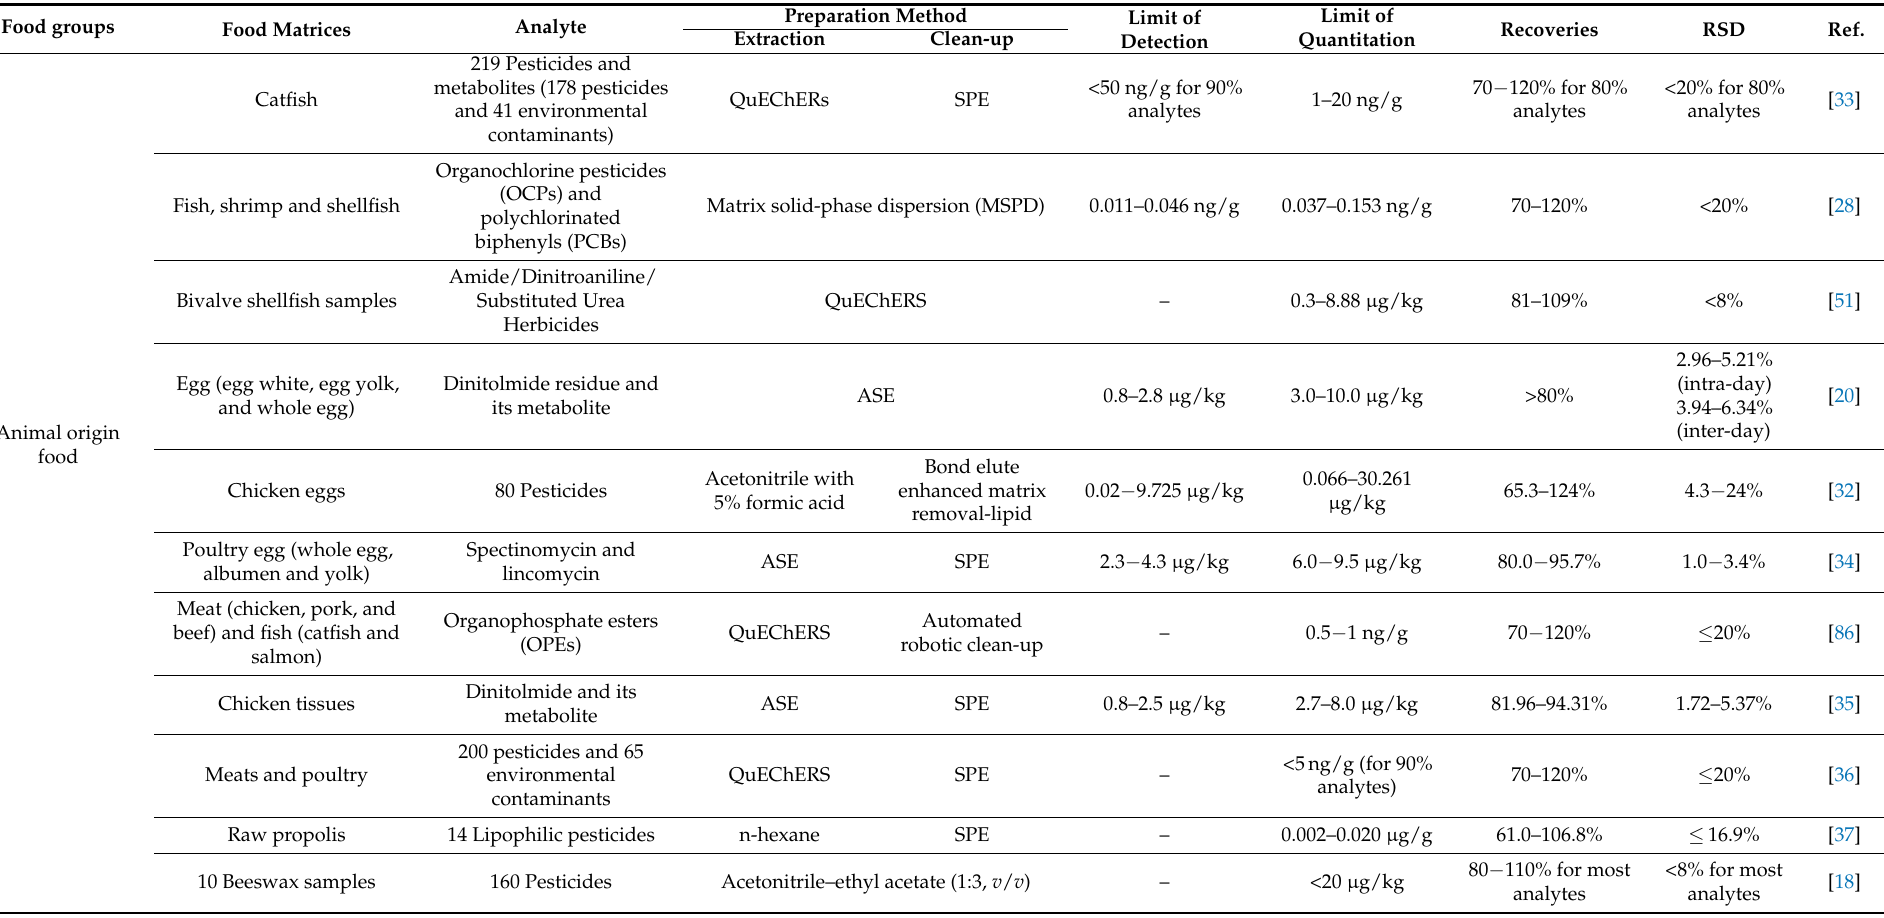
Table 2. Application of preparation methods for semi-volatile organic compounds (SVOCs) analysis in food by GC–MS/MS during the last three years. Food